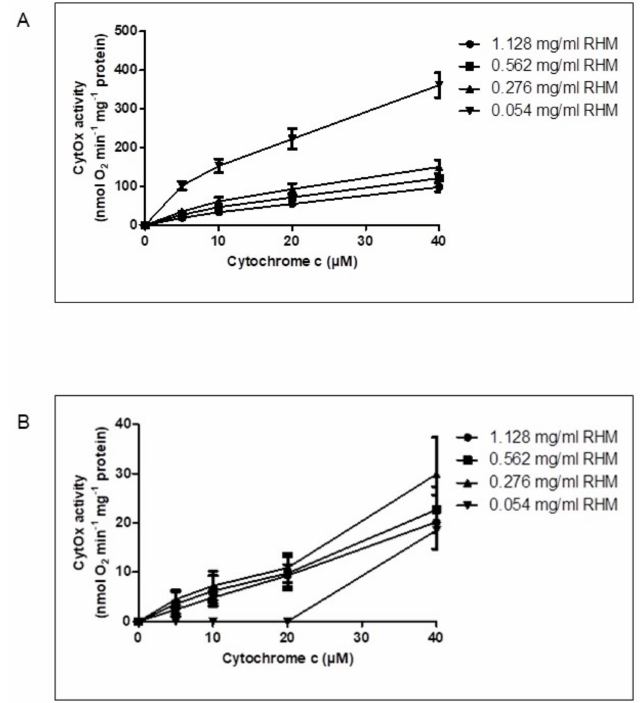
Figure 2. Variation in CytOx kinetics depending on mitochondrial protein concentrations. The activity of CytOx kinetics was measured using 1.128, 0.562, 0.276 and 0.054 mg/mL mitochondrial concentrations at 0, 5, 10 and 40 µ M cytochrome c (substrate of CytOx) in the presence of 18 mM ascorbate, which was used to reduce cytochrome c. ( A ) in the presence of 5 mM ADP, ( B ) in the presence of 5 mM ATP + RS (10 mM PEP + 160 U/mL PK). The activity of CytOx measured in the presence of ADP as well as ATP + RS at lower (0.054 mg/mL) concentration of RHM was significantly different ( p ≤ 0.0001) from all other higher mitochondrial protein concentrations when a regular two-way ANOVA with Bonferroni Post hoc test was applied to the data consisting of n = 4 individual